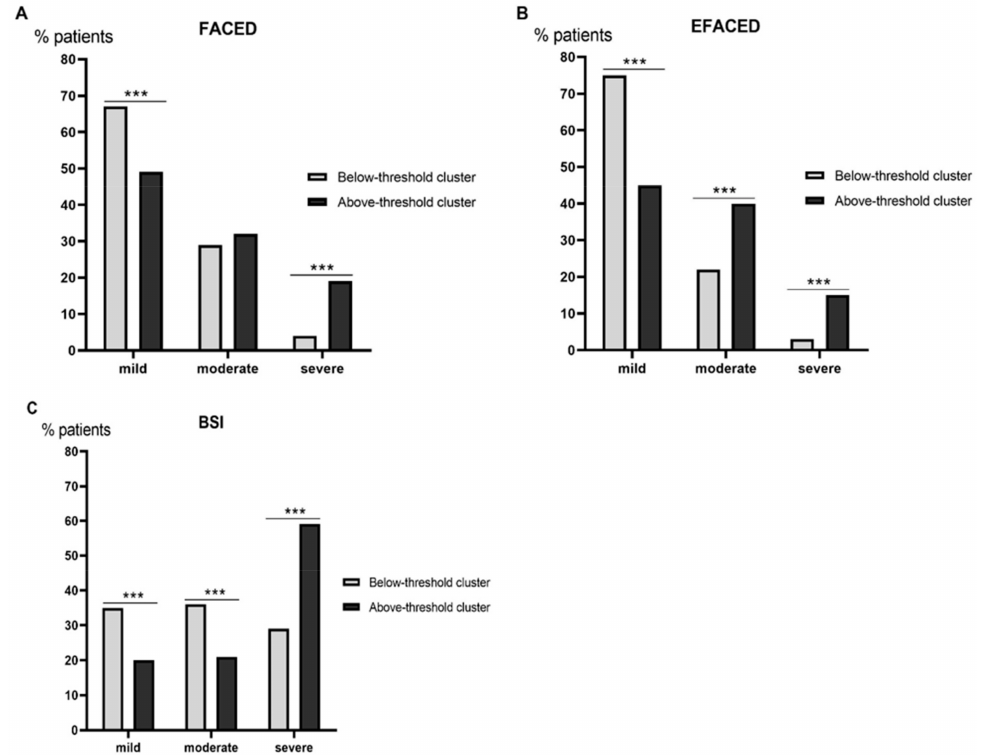
Figure 3. Histograms of the proportions of patients who were classified as mild–moderate–severe according to FACED ( A ), EFACED ( B ), and BSI ( C ) between the two patient clusters. Disease severity scores were calculated as follows: FACED: mild: 0–2, moderate: 3 to 4, and severe: 5–7;